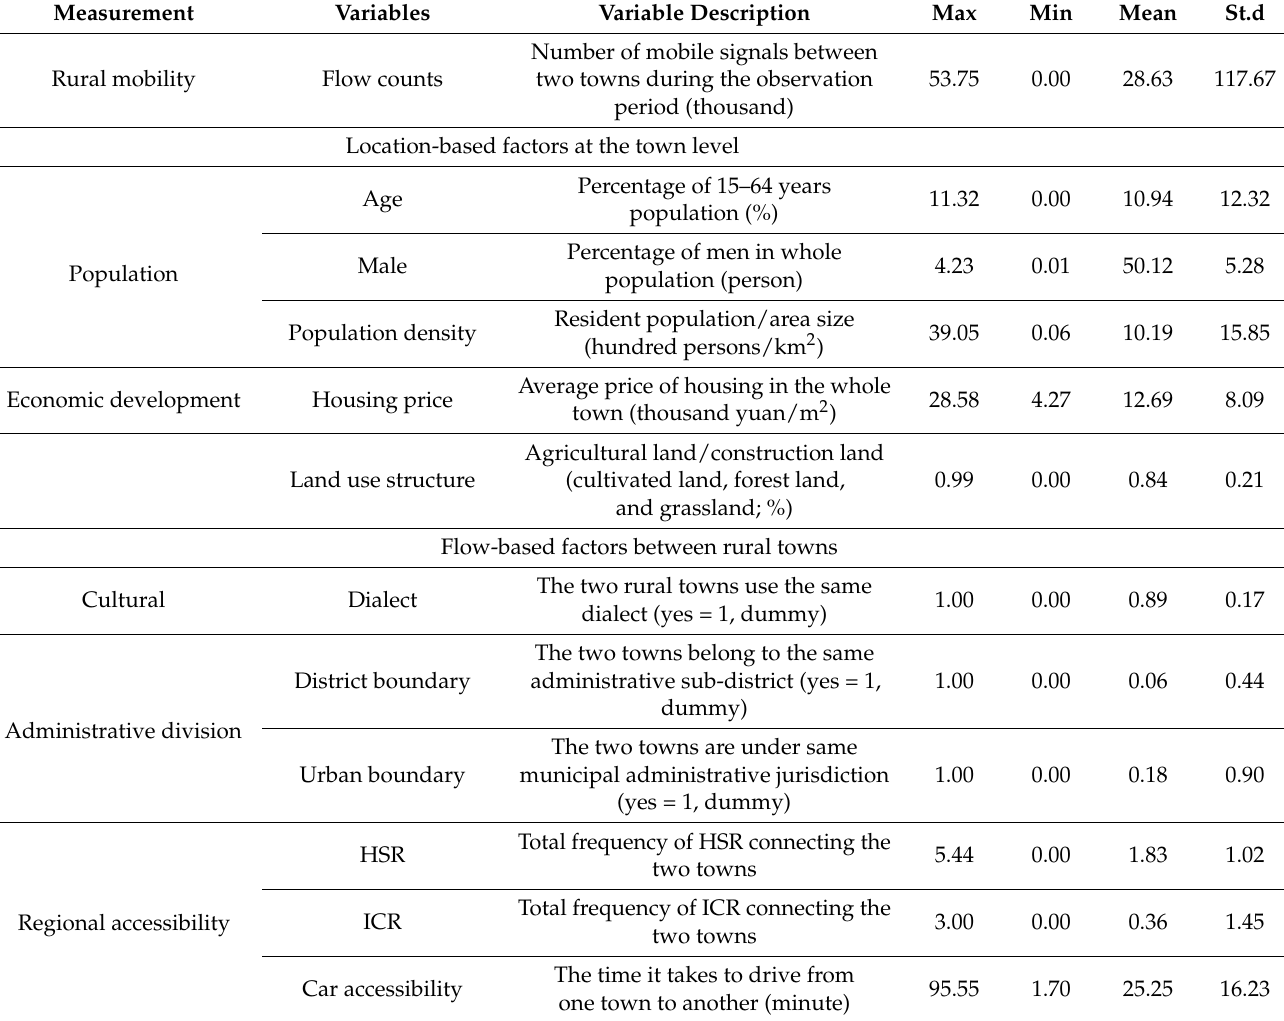
Table 1. Variables and data descriptive